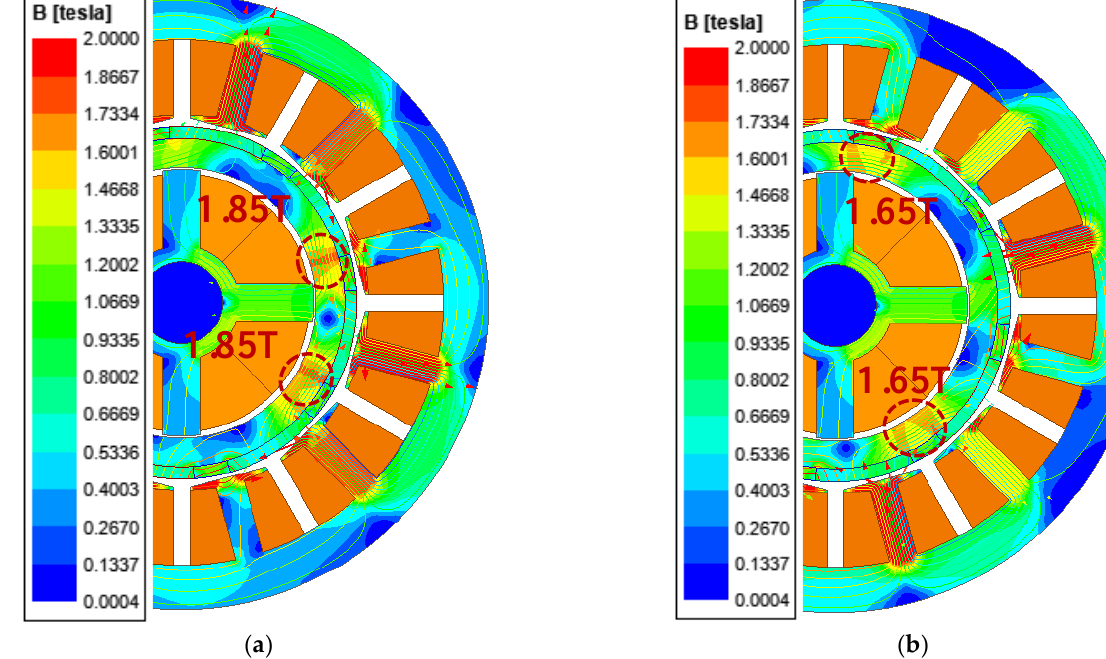
Figure 7. Magnetic saturation plot of shaft according to rotating angle of rotor: Rotating angle: ( a ) 248° electric; ( b ) 178° electric.